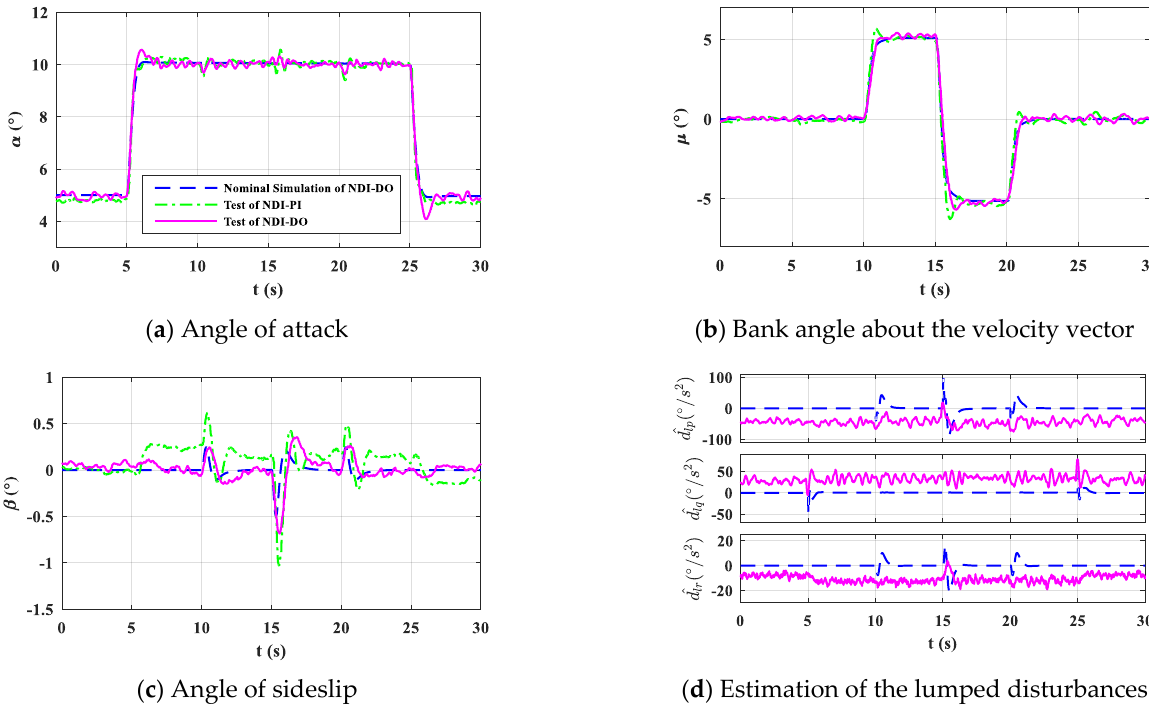
Figure 11. Experimental responses of the tailless aircraft model controlled using NDI-PI and NDI-DO in the wind tunnel flight tests in contrast with the nominal simulation results of NDI-DO.